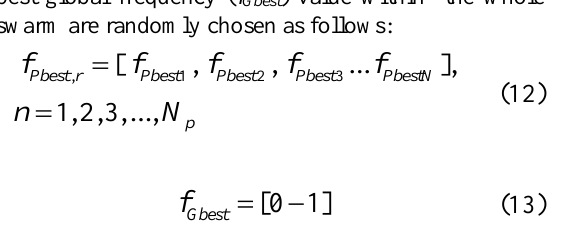
Figure 4. The flow chart for PSO based frequency tracking